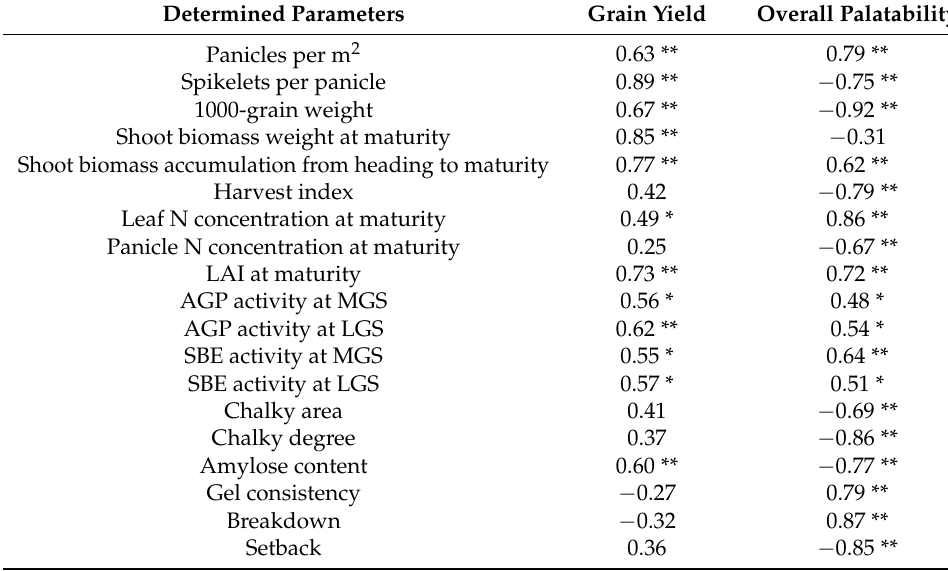
Table 8. Pearson’s correlation coefficients between the determined agronomic and physiochemical traits and the grain yield and overall palatability of the